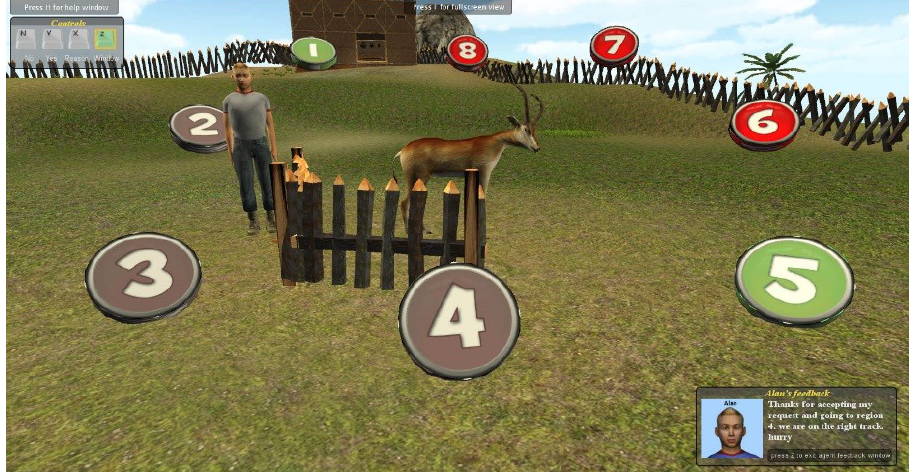
Figure 7. A screenshot from the scenario.